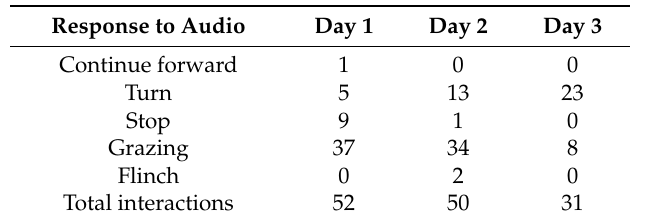
Table 3. Count of behaviours from six sheep, displayed in response to the audio cues over the three days the virtual fence was implemented.